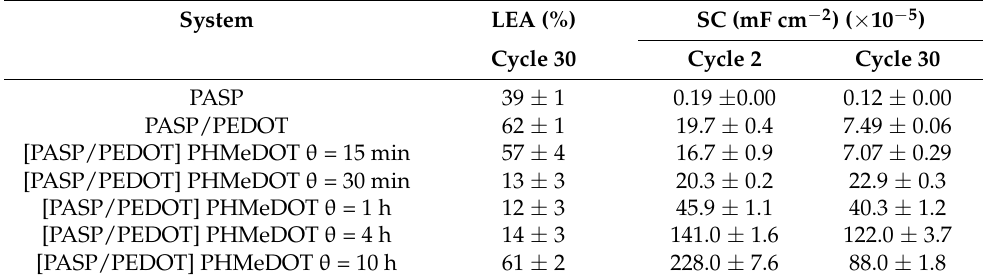
Table 2. LEA (at 30th cycle, in %) and SC values (in mF cm − 2 ) determined from CV curves at the 2nd and 30th cycles for PASP, PASP/PEDOT, and [PASP/PEDOT]PHMeDOT hydrogels systems at different anodic polymerization times ( θ ). Standard deviation is also